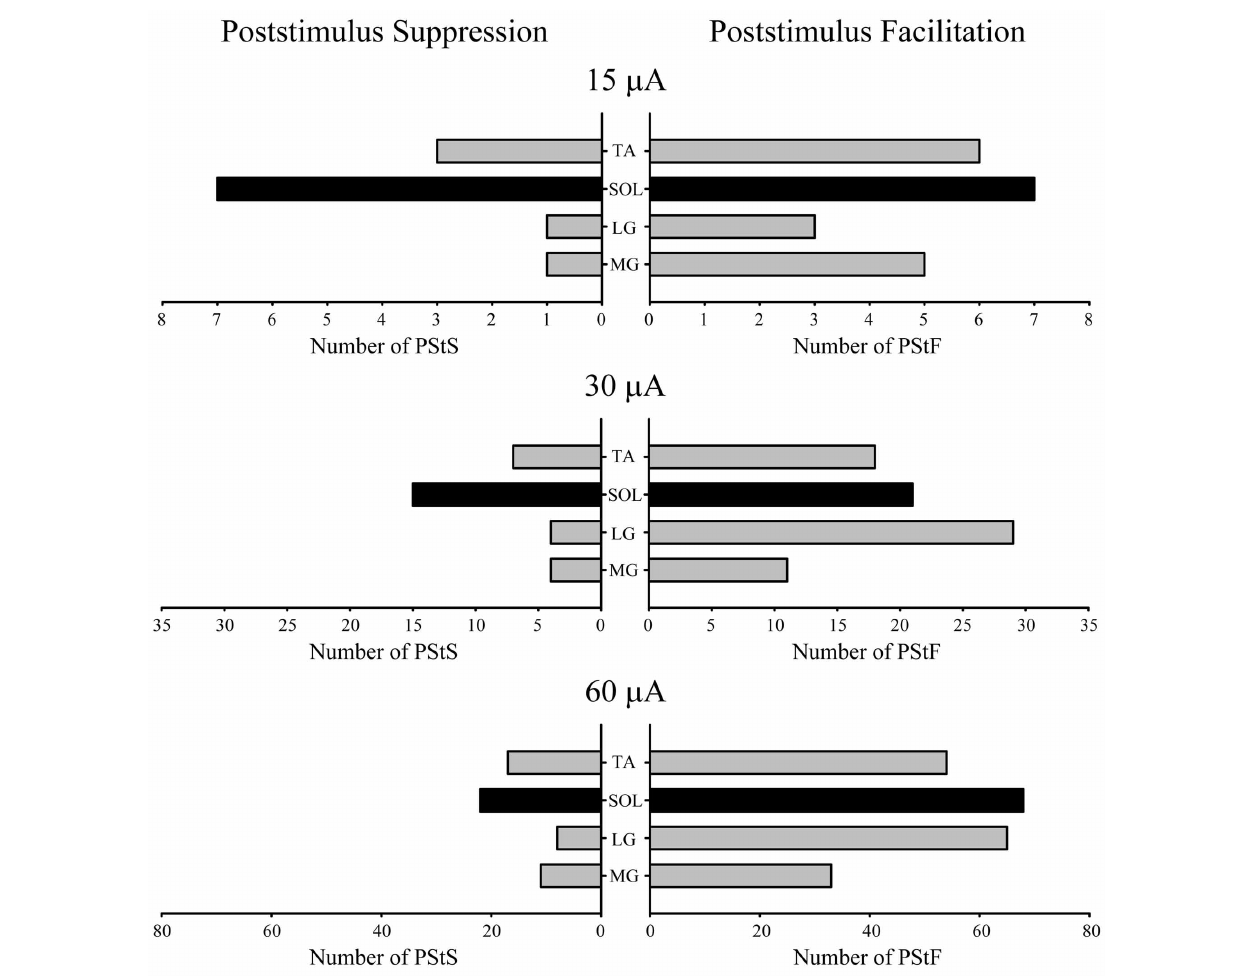
FIGURE 5 | Distribution of PStF (right) and PStS (left) effects obtained from four ankle muscles of the hindlimb at 15, 30, and 60 µ A stimuli. Gray bars: fast muscles. Black bars: slow muscle. Muscle abbreviations are the same as in Figure 1